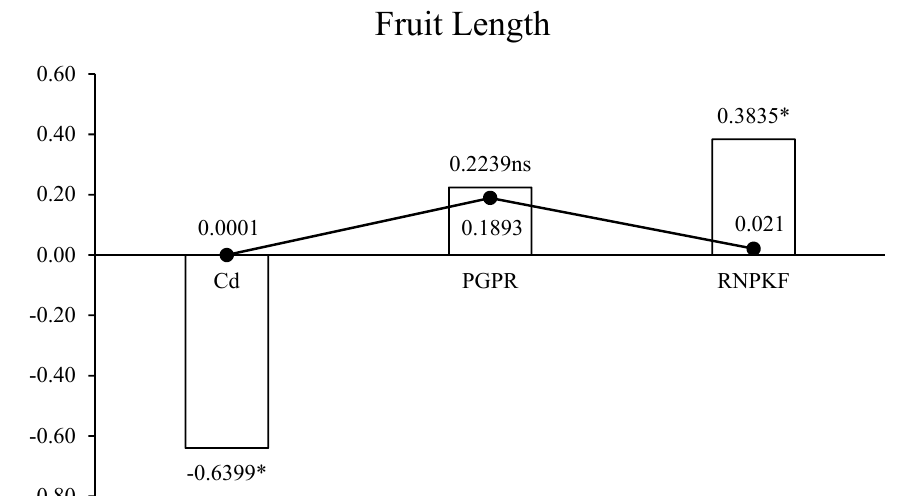
Figure 4. Bitter gourd fruit length (cm) treated with PGPRs, RNPKF, and their combination under 2 and 5 mg Cd kg − 1 soil. Different small letters express significant differences at p ≤ 0.05.